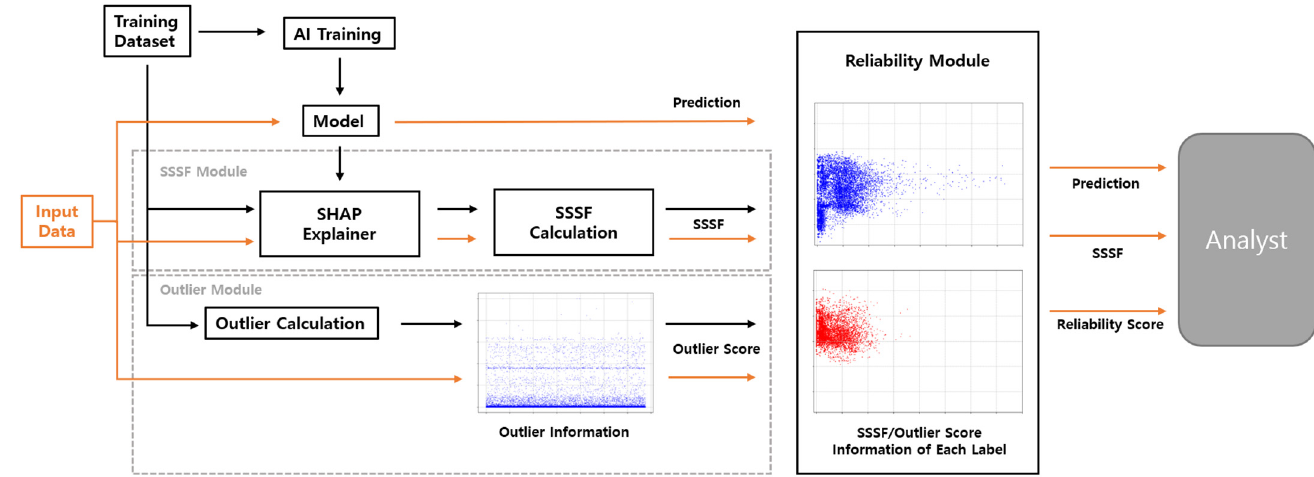
Figure 1. Overall structure of the proposed method.